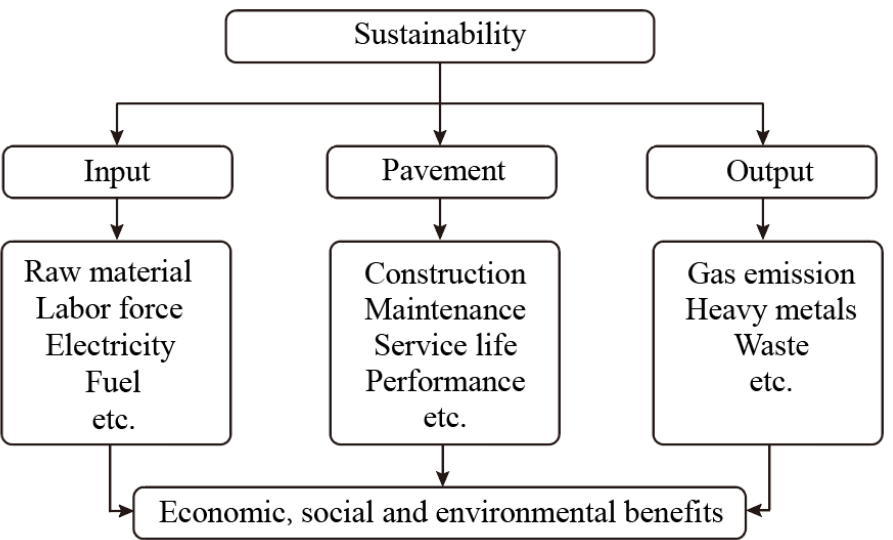
Figure 9. A typical framework for assessing the sustainability of an asphalt pavement.